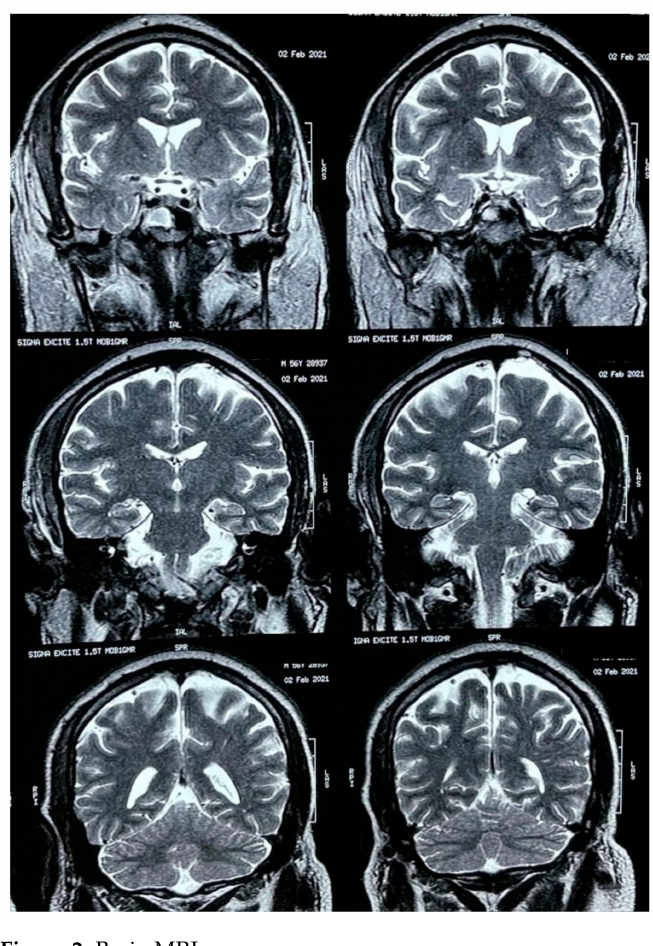
Figure 2. Brain MRI.